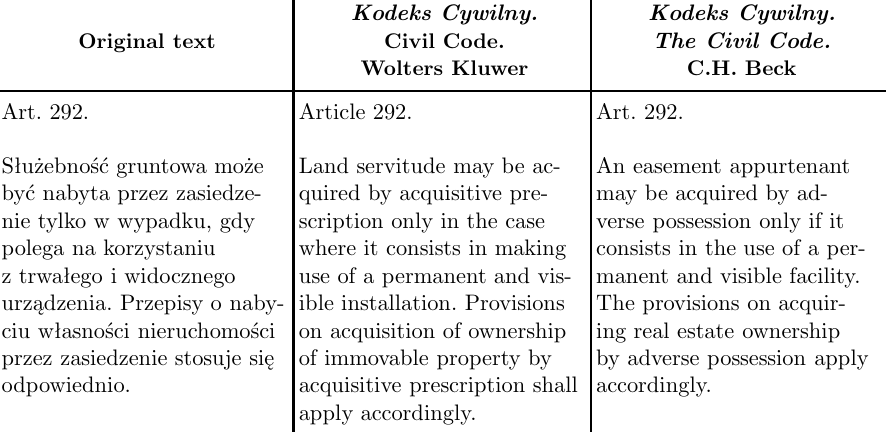
Comparison of two translations of Art. 292 of the Polish Civil Code Kodeks Cywilny. Kodeks Cywilny. Original text Civil Code. The Civil